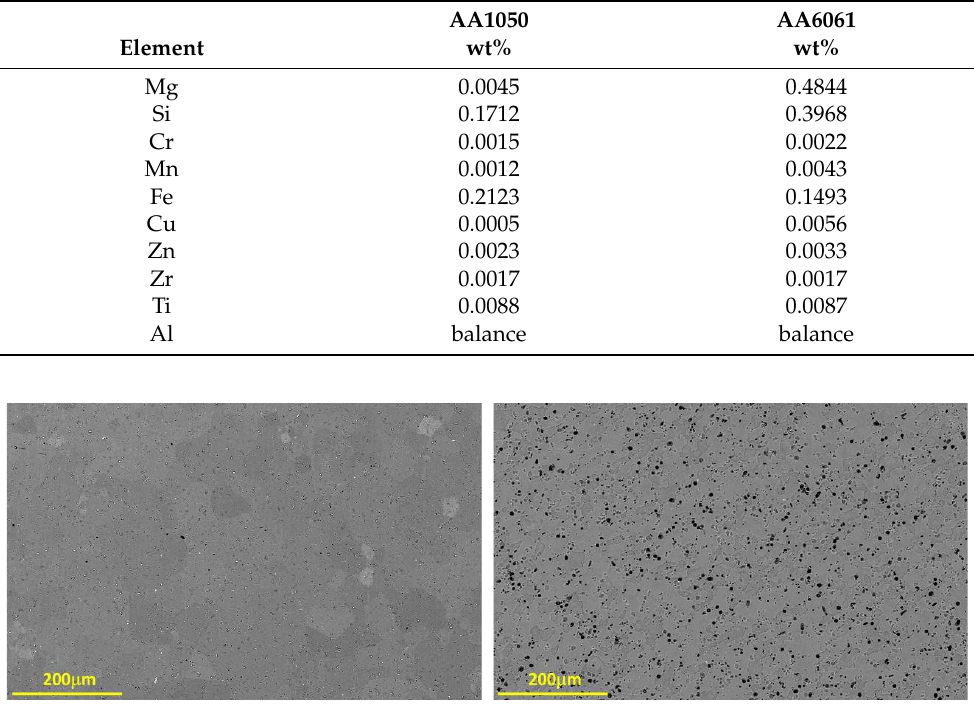
Table 2. Chemical composition of AA1050 and AA6061 aluminum alloys in wt%.